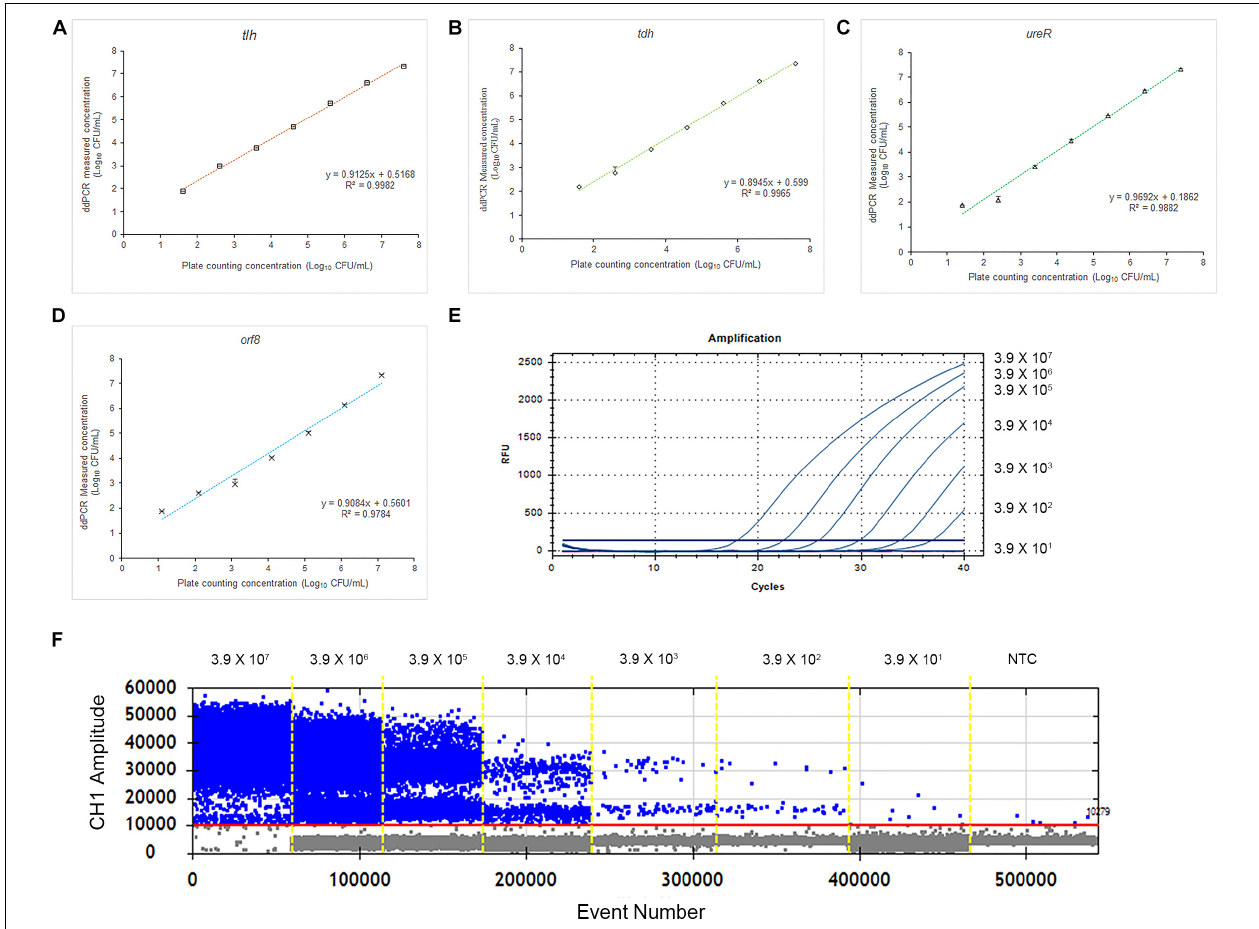
FIGURE 4 | Quantification of V. parahaemolyticus by plate counting, qPCR, and ddPCR. (A) Standard curves of tlh in 4-plex ddPCR. Comparative analysis of diluted series of indicated bacterial solution. The horizontal axis was plate counting detection results for V. parahaemolyticus. (B) Standard curves of tdh in 4-plex ddPCR. (C) Standard curves of ureR in 4-plex ddPCR. (D) Standard curves of orf8 in 4-plex ddPCR. (E) Fluorescence curves were obtained based on qPCR by using the same templates. (F) The picture of FAM channel of the 4-plex ddPCR by using the same templates. Plotted values represented the mean value and standard deviations obtained from three triplicate tests. NTC = non-template